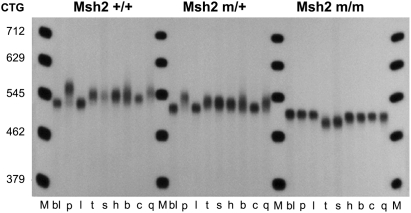
Somatic mosaicism in 8-month-old Msh2+/+
,
Msh2G674A/+ and Msh2G674A/G674A transgenic males.bl, blood; p, pancreas; l, liver; t, testis; s, sperm; h, heart; b, brain; c, cerebellum; q, quadriceps. M. 250 bp DNA ladder converted to number of CTG repeat units in the given PCR product. Msh2 +/+/, m/+ and m/m represent genotypes at the murine locus for Msh2. +: wild-type allele; m: Msh2G674A mutation. The Msh2 +/+, m/+ and m/m males in tail extracted DNA at weaning contained 525, 516 and 500 CTG repeats, respectively.